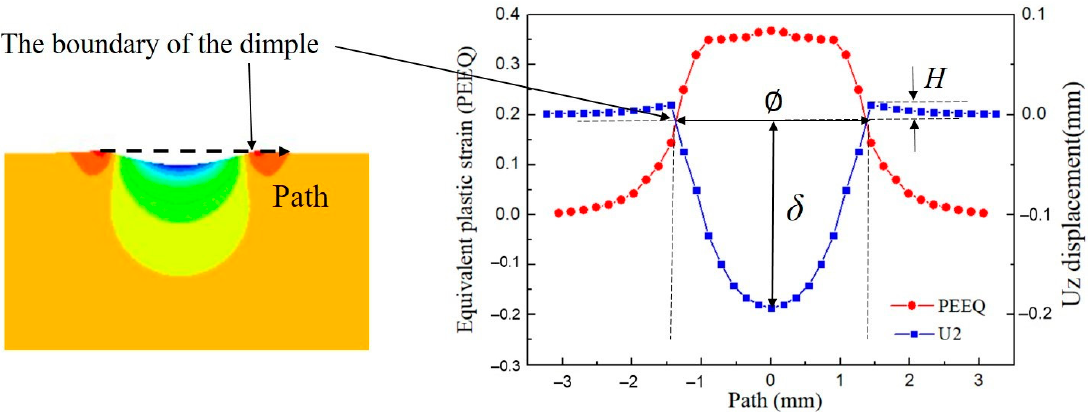
Figure 5. Definitions of the dimensions of the dimple and the height of the pile-up.